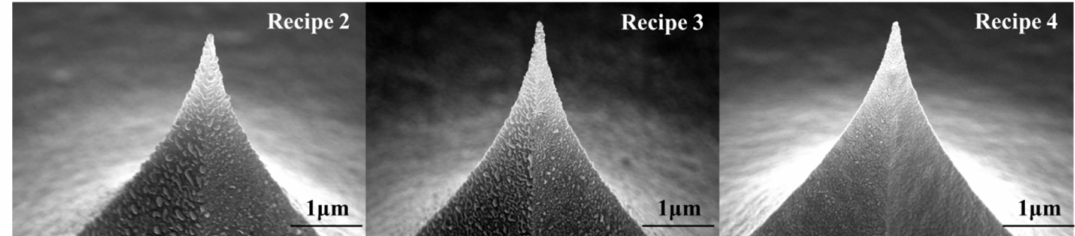
Figure 7. Tip morphology after different annealing